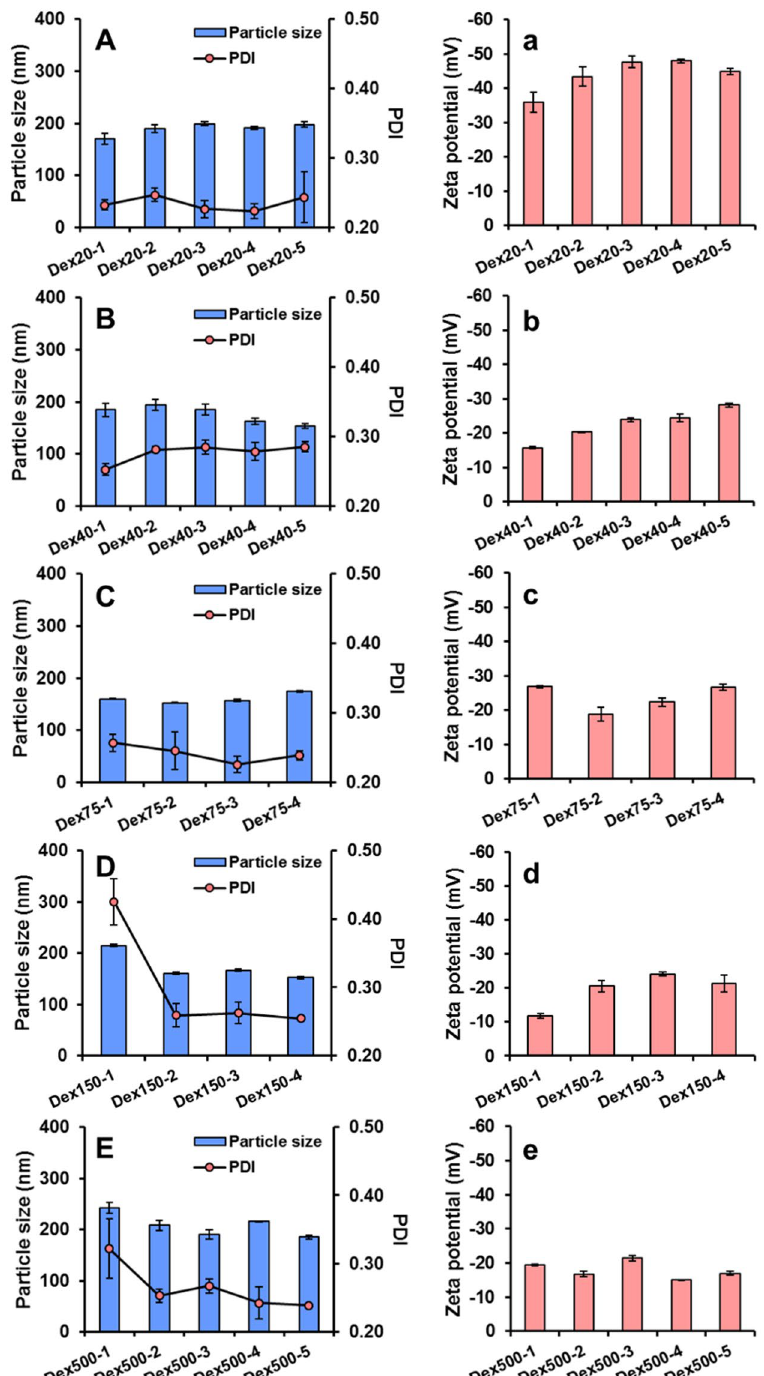
Figure 4. Particle size, PDI ( A–E ), and zeta potential (a–e) of LPN (prior to pectin coating) prepared using Maillard conjugates with different molecular weight dextran. The groups Dex75-5 and Dex150-5 formed gels and were not completely solubilized in water, and thus their results were